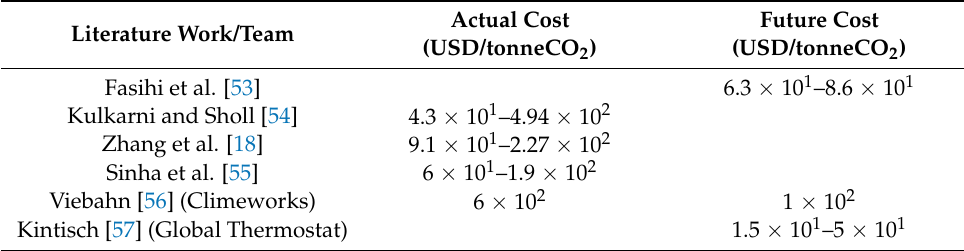
Table 3. Estimated costs for adsorption